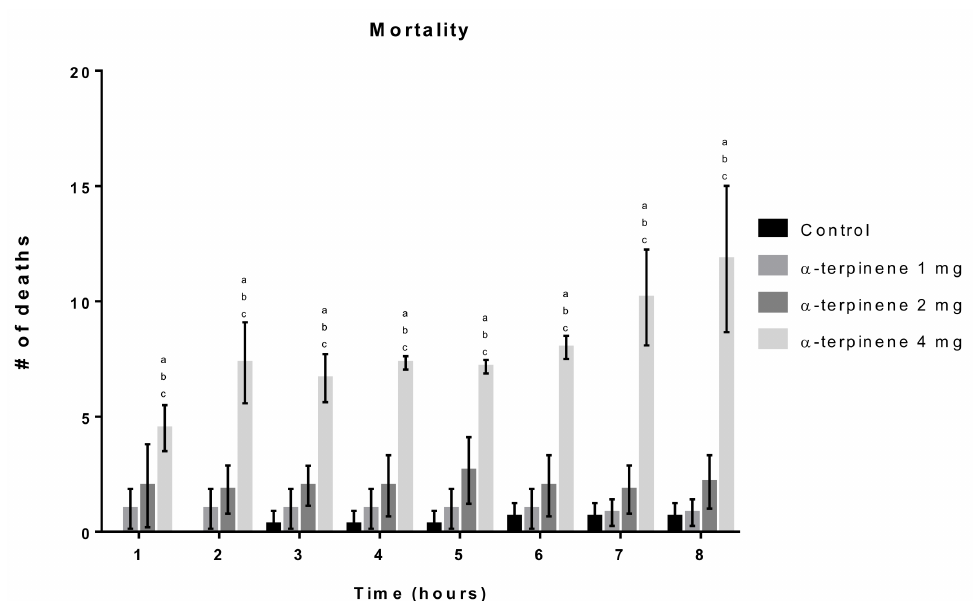
Figure 5. Effect of α -terpinene on D. melanogaster survival. Subtitles: Survival was analyzed at the indicated time points. Results are expressed as the Mean ± SD of the number of dead flies after each exposure time. a = p < 0.05 compared to the control, b = p < 0.05 compared to 1 mg/mL and c = p < 0.05 compared to 2 mg/mL.